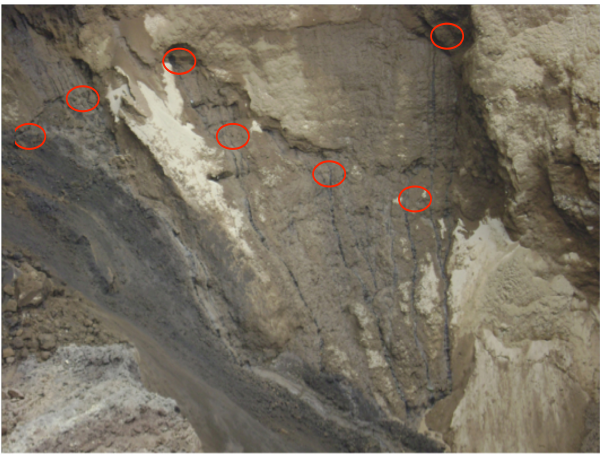
Figure 6. Southern and southwestern side of the inner part of the sinkhole, where water flows.